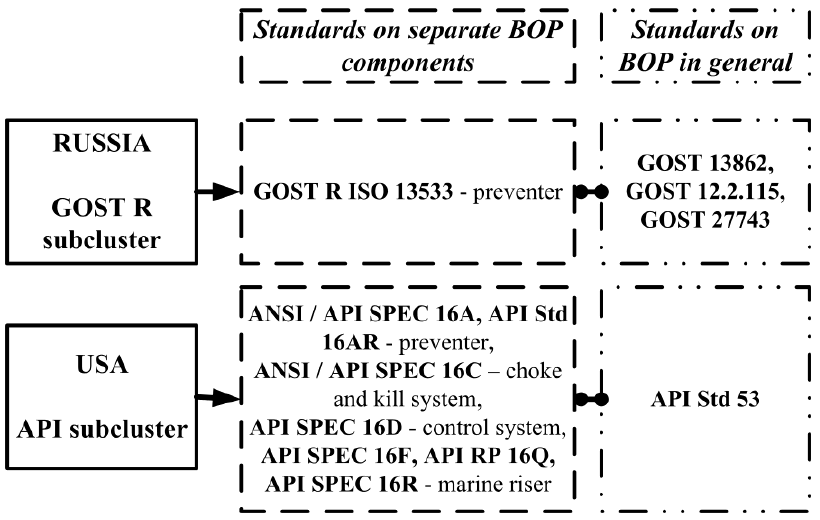
Figure 3. Foreign and Russian standards on